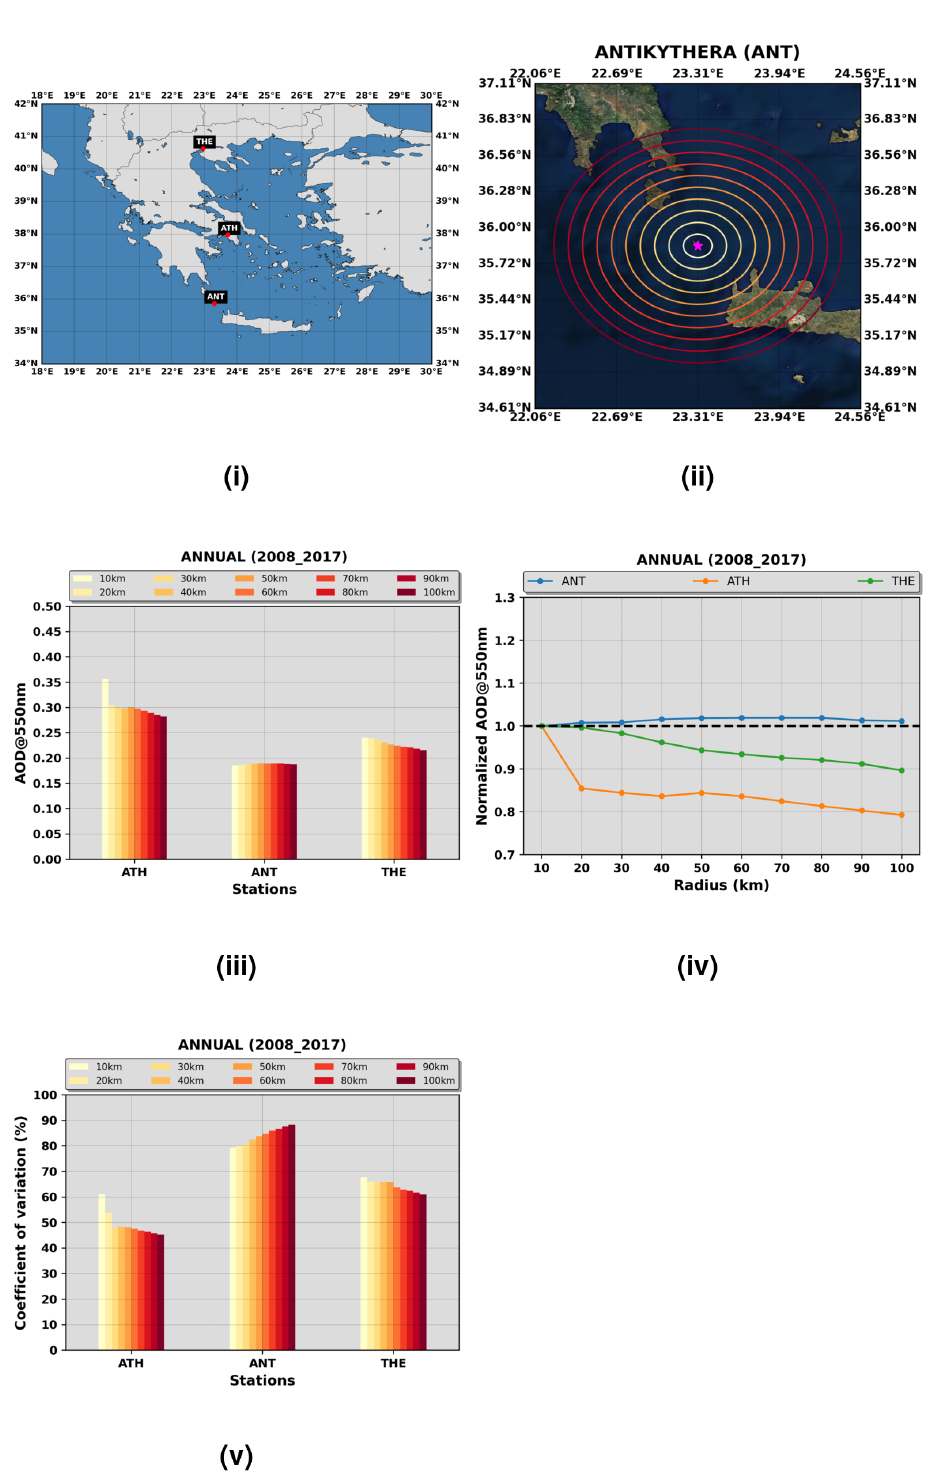
Figure 1. (i) Locations of the three Greek PANACEA sites, namely Athens (ATH), Antikythera (ANT) and Thessaloniki (THE). (ii) Concen- tric circles, around Antikythera island, of radii from 10 to 100km, with an incremental step of 10km. (iii) Climatological MODIS Aqua AOD levels, representative of the period 2008–2017, for each circle area centred at each PANACEA site. (iv) Normalized climatological AODs for each circle area with respect to the corresponding levels of the inner circle. (v) Coefficient of variation (CV; expressed in percentage) of MODIS Aqua AOD, representative of the period 2008–2017, for each circle area centred at each PANACEA site. Atmos. Meas. Tech., 16, 1017–1042,